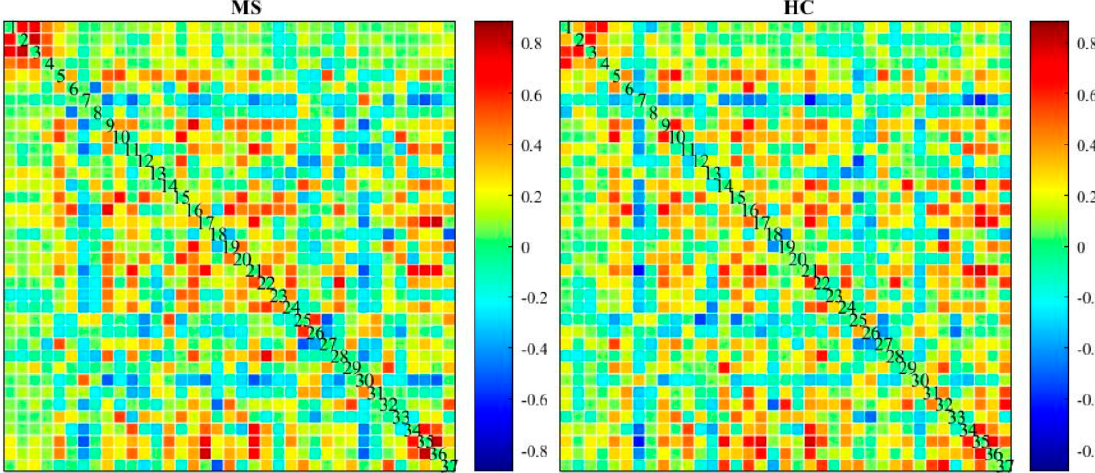
Figure 8. Two-sample t-test for dynamic connectivity map for MS and HC group .